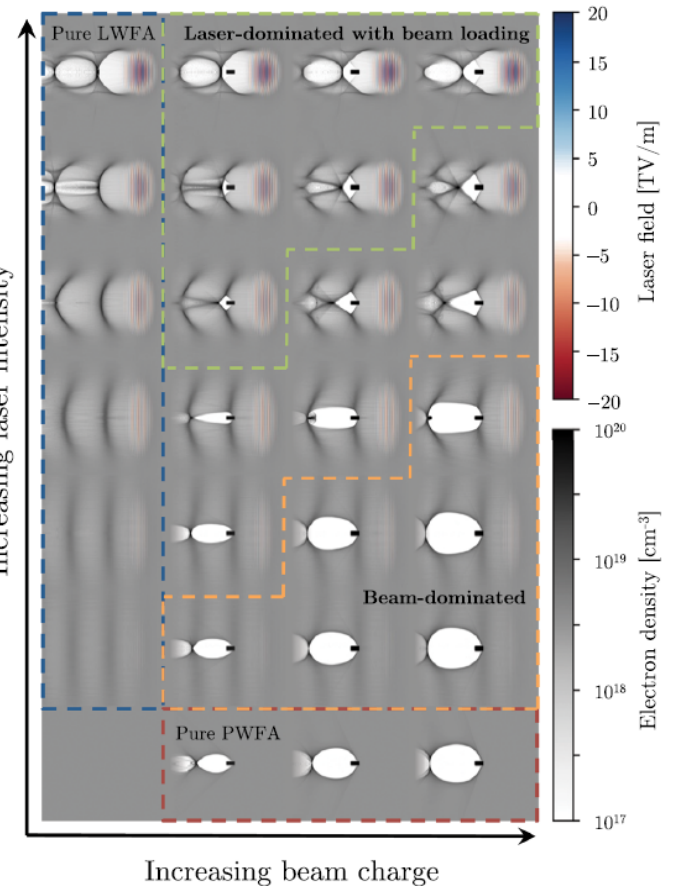
Figure 8. Overview showing a classification of laser pulse vs. electron-beam-dominated wakefield regimes (figure adapted from [15]). The electron beam charge density ( x -axis) and the laser pulse intensity ( y -axis) are responsible for the wake excitation and are, hence, decisive for the type of plasma wakefield that is